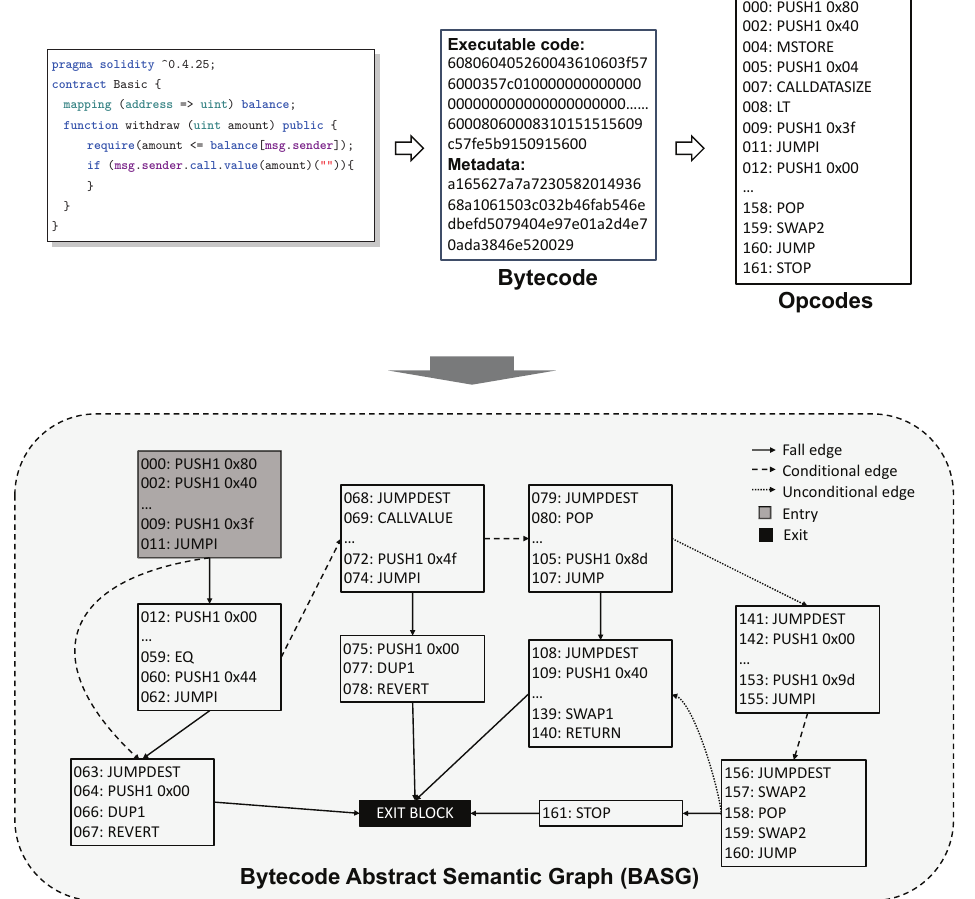
Figure 5. Bytecode abstract semantic graph generation based on basic block sequences and enriched by control